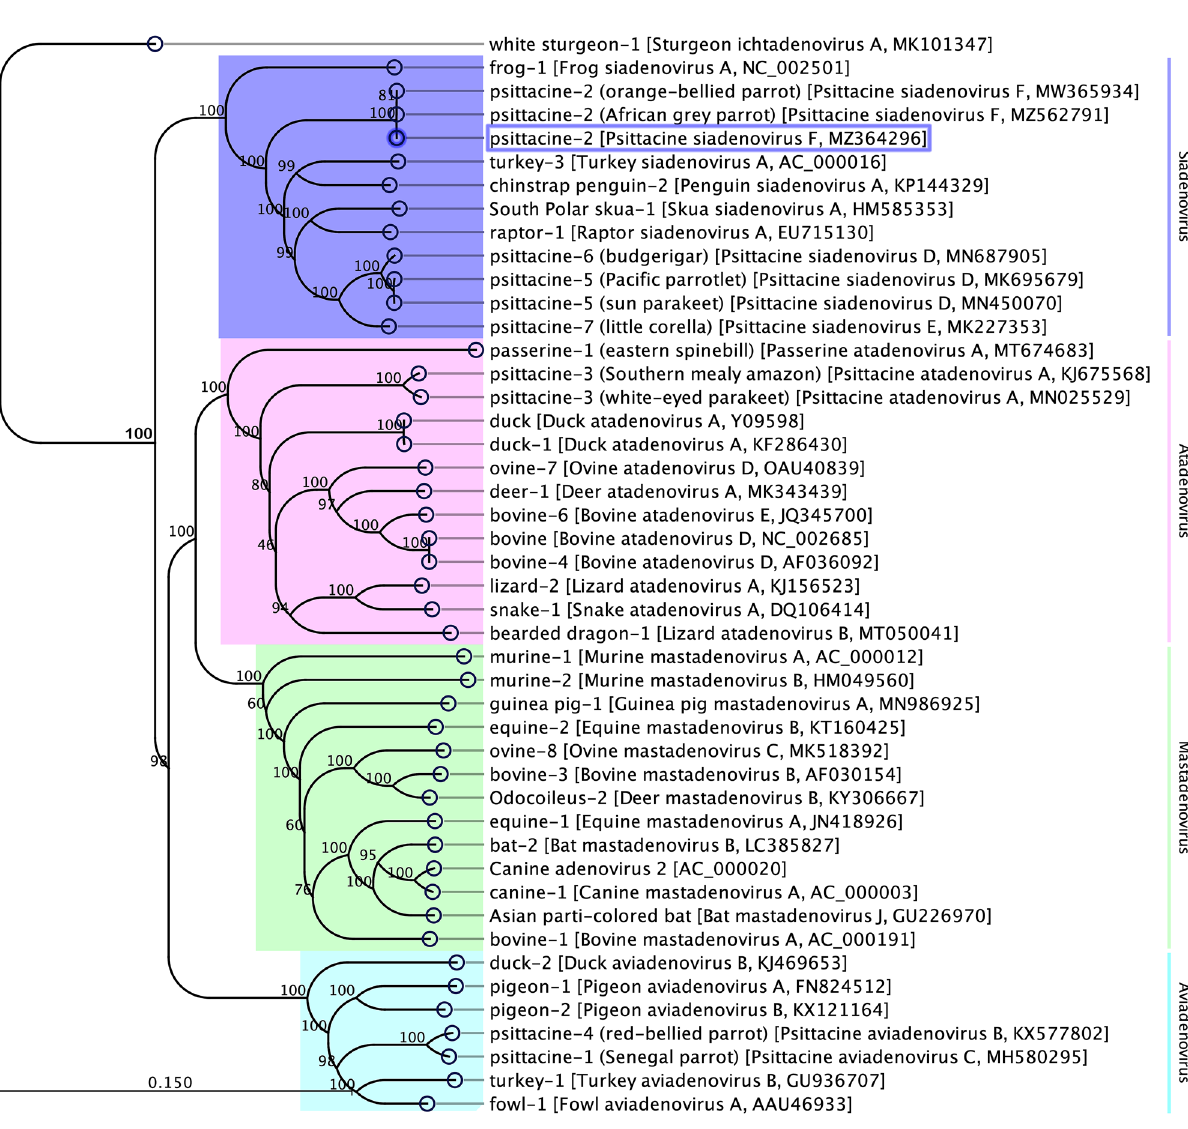
Figure 1. The phylogenetic tree shows the possible evolutionary relationship of PsSiAdV-F strain S10/AU with other selected AdVs. The maximum likelihood (ML) tree was constructed by using concatenated amino acid sequences of the complete DNA-dependent DNA polymerase, pTP, penton and hexon genes. Concatenated protein sequences were aligned with MAFTT (version 7.450) 65 in Geneious (version 10.2.2, Biomatters, Ltd., Auckland, New Zealand), under the BLOSUM62 scoring matrix and gap open penalty = 1.53. The gap > 20 residues deleted from the alignments. The ML tree was constructed under the WAG substitution model, and 1000 bootstrap re-samplings using tools available in CLC Genomics Workbench (version 9.5.4). The numbers on the left show bootstrap values as percentages, and the labels at branch tips refer to original AdVs host species followed by AdVs name and GenBank accession numbers in parentheses. The clade correspondence to the genus Siadenovirus is highlighted in pink, and the PsSiAdV-F sequenced in this study is shown in the blue A-E) were found to be unique according to the BLAST database. Among the predicted protein coding ORFs of the PsSiAdV-F strain S10/AU genome, 25 were homologs to a recently sequenced PsSiAdV-F strain OBP2209 gene products (Table 1). The amino acid sequence similarity of predicted ORFs was very high compared to other siadenoviruses, ranging from 98.7 to 100% (Table 1). Phylogenetic analyses based on two non-structural (polymerase and pTP) and two structural (penton and hexon) protein sequences clearly supported the inclusion of the newly sequenced PsSiAdV-F strain S10/AU in the genus Siadenovirus . In the resulting ML tree, based on concatenated amino acid sequences of four selected AdVs genes, the sequenced PsSiAdV-F strain S10/AU was positioned in a distinct subclade with other two PsSiAdV-F strains (e.g., OBP2209 and WVL19065-01E) (100% bootstrap support) (Fig. 1). Considering the genome-wide identities (> 99%) and phylogenetic position among three strains of PsSiAdV-F, it is reasonable to postulate that the PsSiAdV-F originates from the same ancestor.